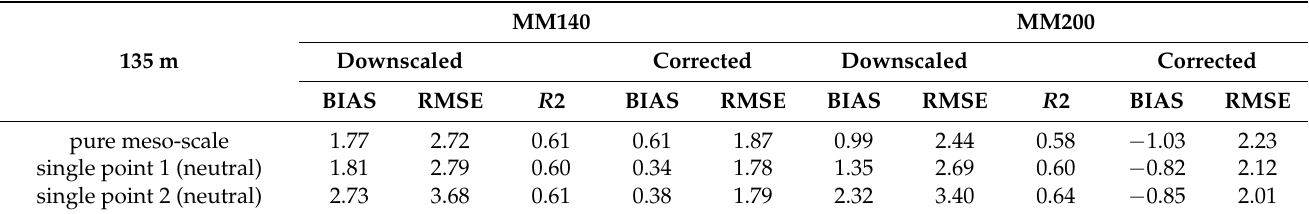
Table 1. Statistical analysis of single-point downscaling methods at two metmast positions on site Rödeser Berg.